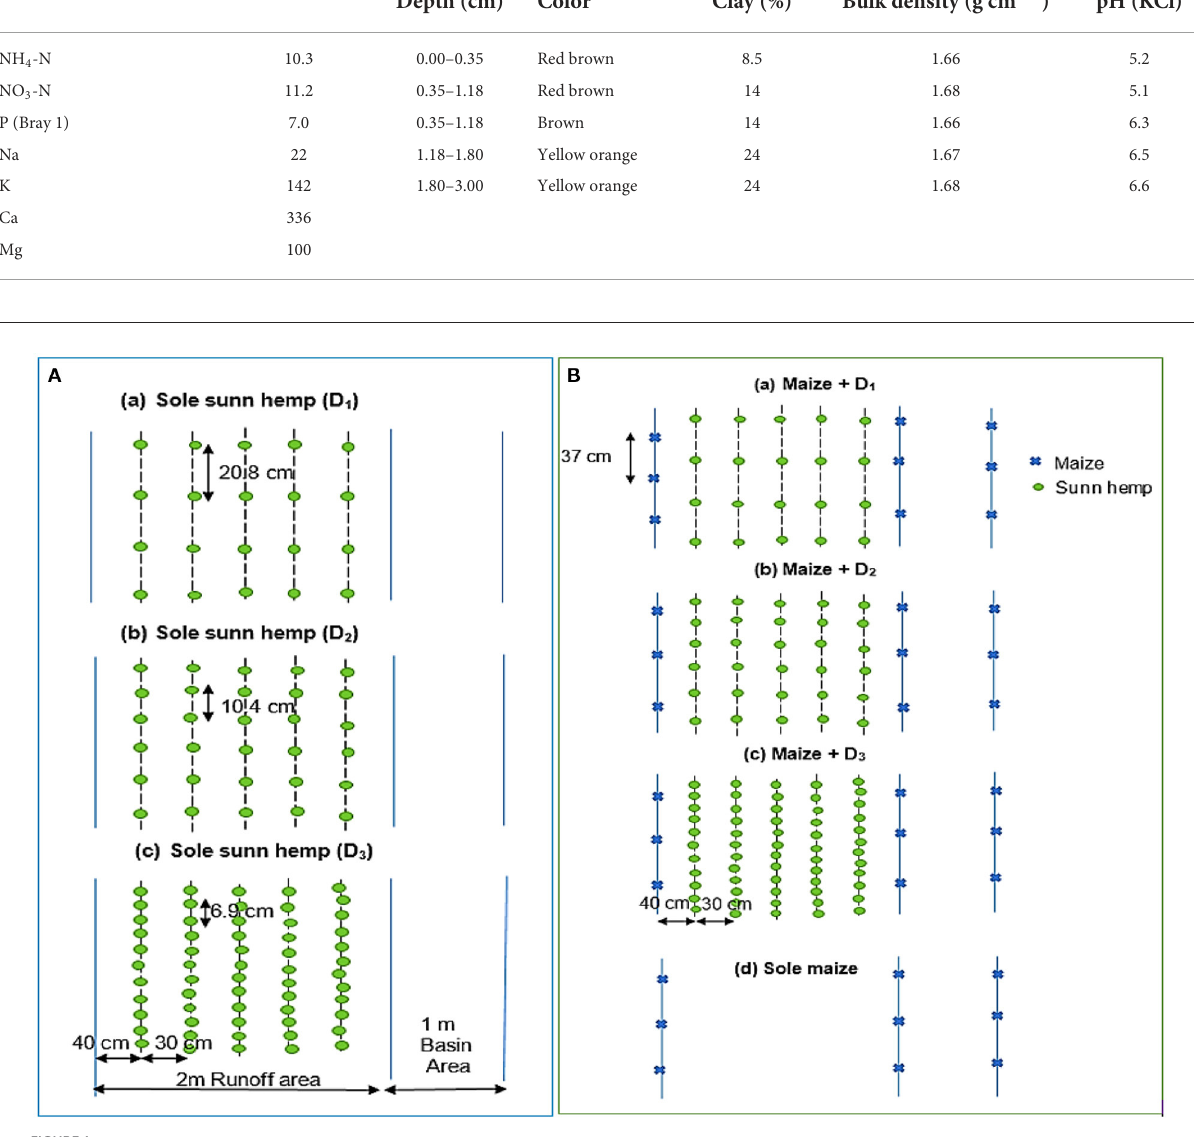
with maize planting (P1), V15 maize growth stage (P2), and R1 maize growth stage (P3) assigned to the main plot.